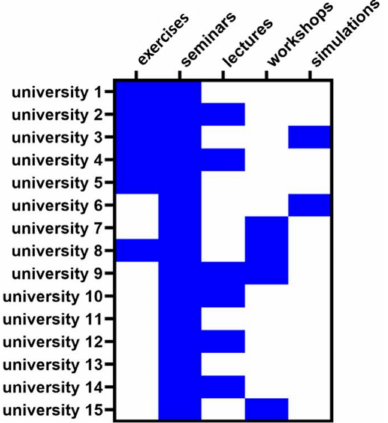
Figure 4. Heat map showing the frequencies with which the Polish medical schools use various formats to teach the medical humanities. Blue color—teaching format used; white color—teaching format not used. The universities are coded with numbers, and the coding is the same as in Table 1 and Figure 3.